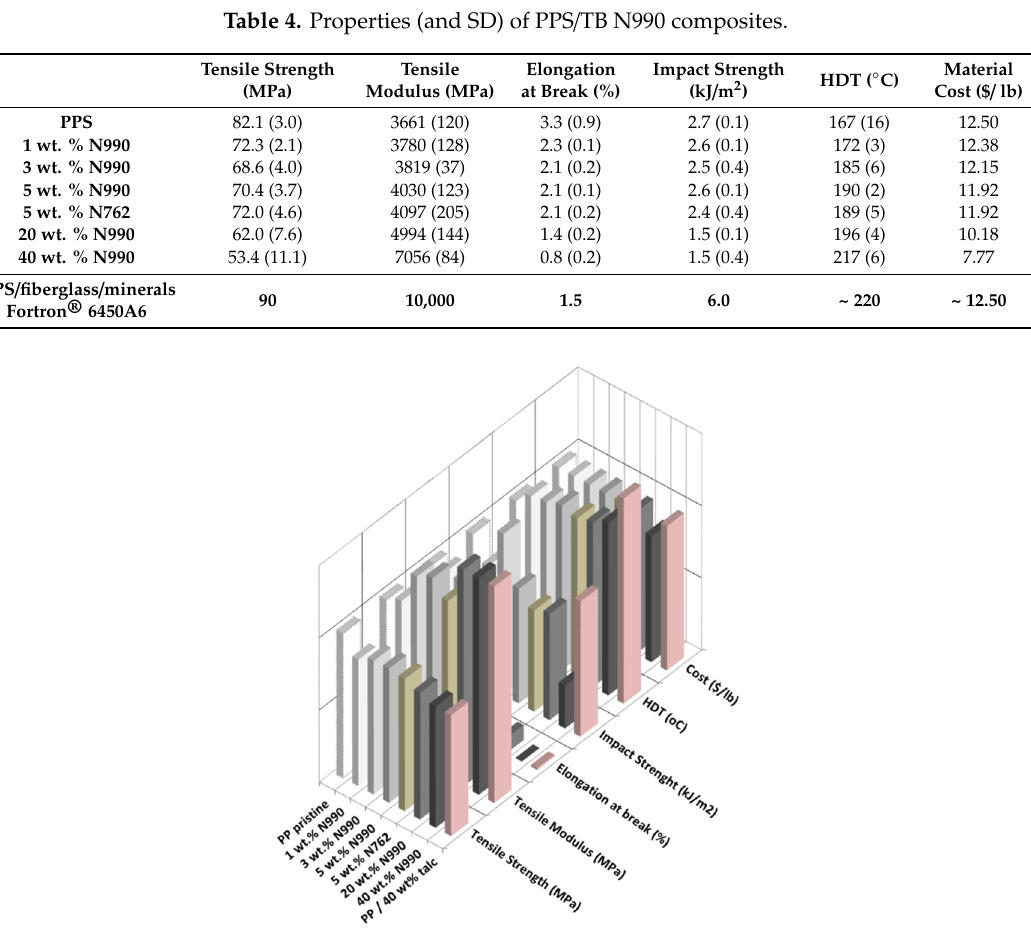
Table 3. Properties (and SD) of PA6/TB N990 composites.